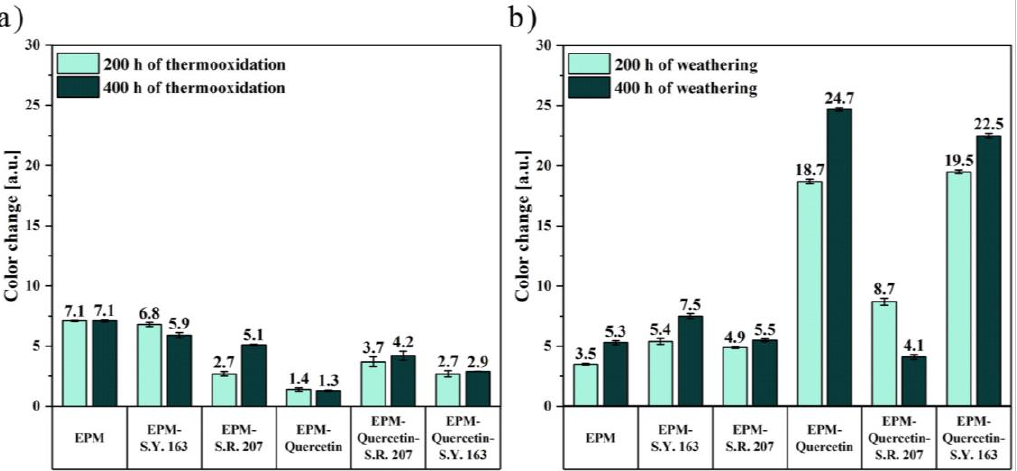
Figure 8. Total color difference (ΔE) of EPM composites subjected to ( a ) thermo-oxidation and ( b ) weathering for 200 and 400 h, respectively.